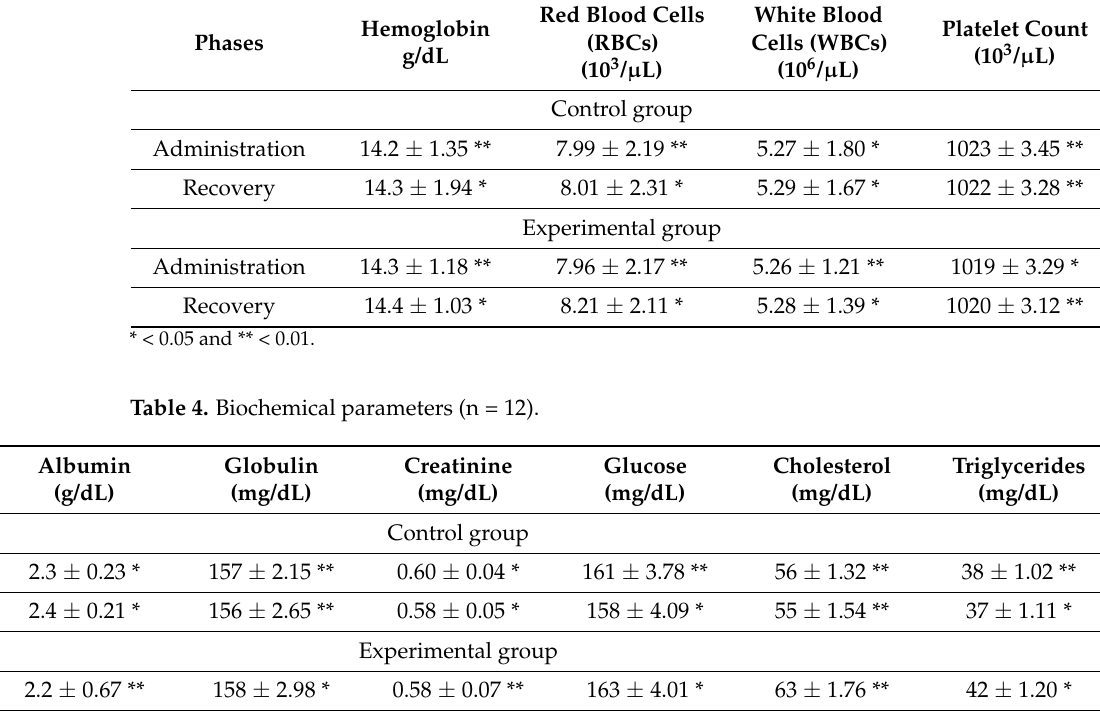
Table 3. Hematological parameters (n = 12).